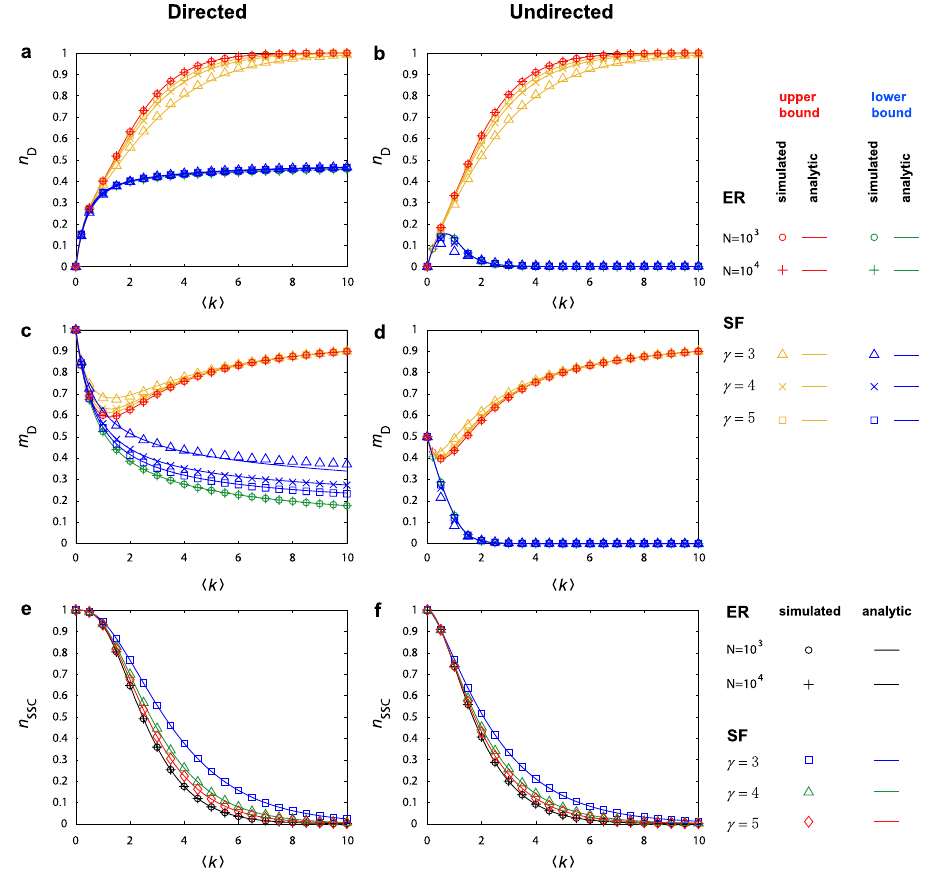
Figure 3. Controllability bounds and strong structural controllability of model networks. For directed and undirected ER and SF networks, ( a , b ) upper and lower bounds of n D , ( c , d ) upper and lower bounds of m D , and ( e , f ) strong structural controllability measure n ssc as a function of the average degree 〈 k 〉 . γ is the scaling exponent of the SF network. The data points are numerical results and the curves represent analytical formulas. All the numerical results are obtained by averaging over 50 independent networks realizations. The other parameters are the same as in Table 1. See Methods and Supplementary Note 9 for network